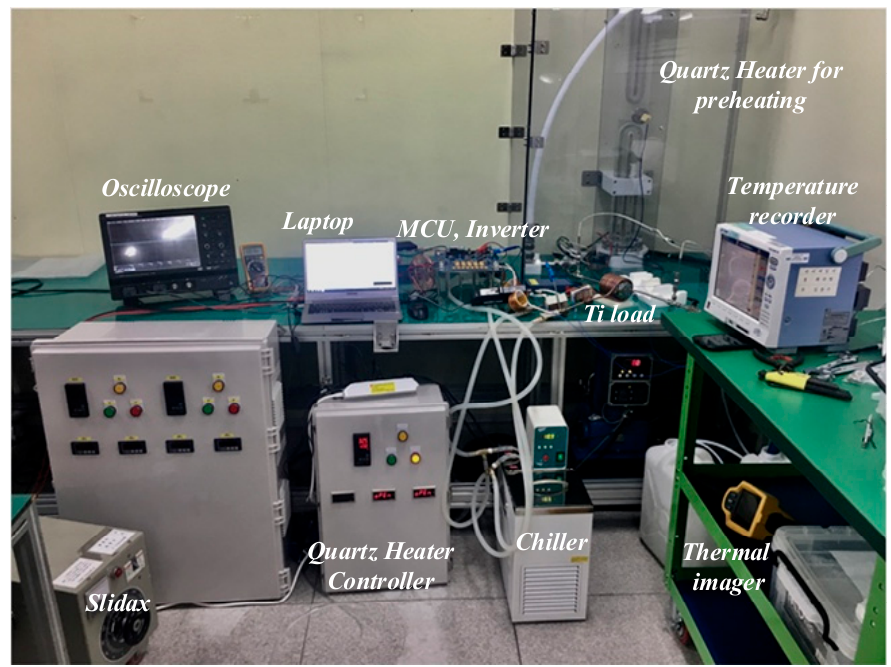
Figure 16. Test bed for SHS generation.